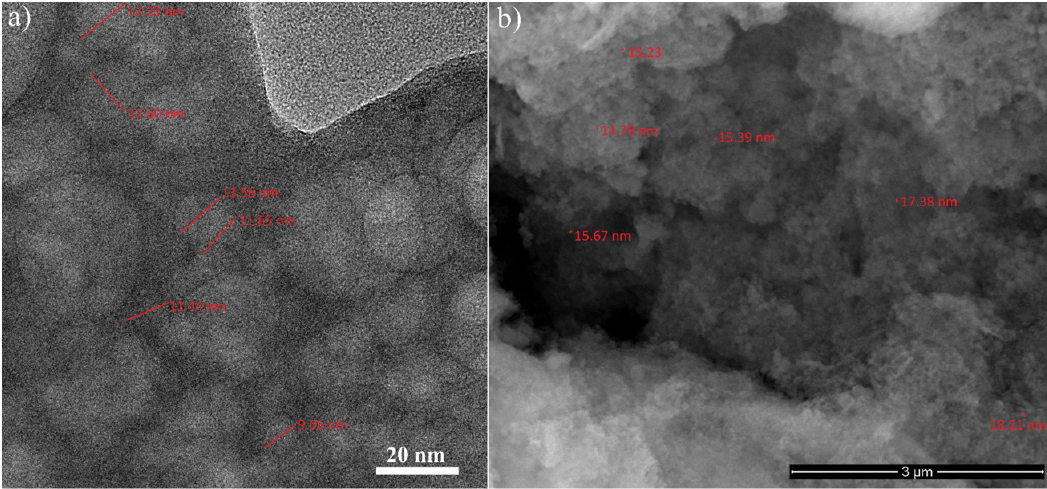
Figure 8. TEM ( a ) and SEM ( b ) images of 25MgHAp particles in suspension.